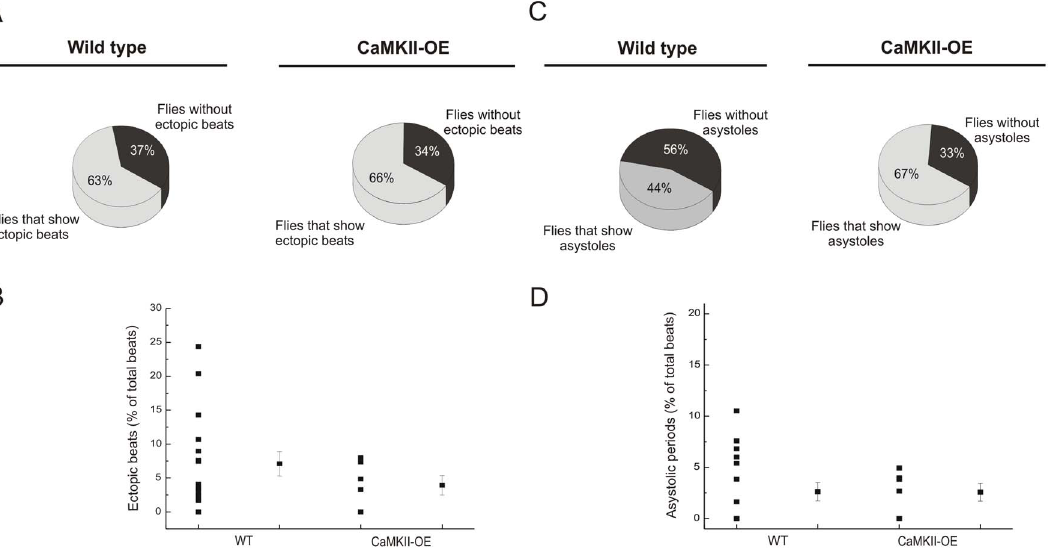
Figure 8. CaMKII overexpression did not affect the occurrence of ectopic beats and asystoles. CaMKII-OE flies did not exhibit changes on ectopic beats and asystoles compared with WT flies (A, C). Percentage of ectopic beats and asystoles over total beats were not different between control and CaMKII-OE flies (B, D). Mean 6 SEM of 28 flies. *p # 0.05.